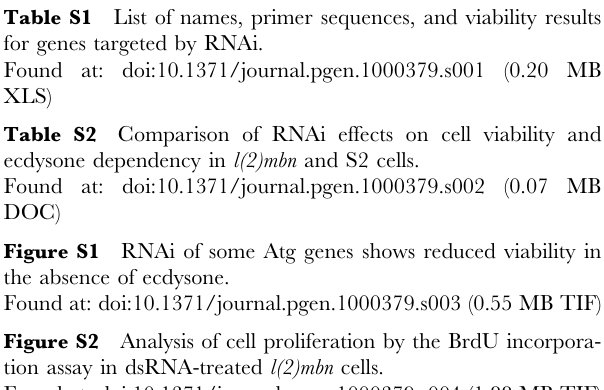
Table S1 List of names, primer sequences, and viability results for genes targeted by RNAi.